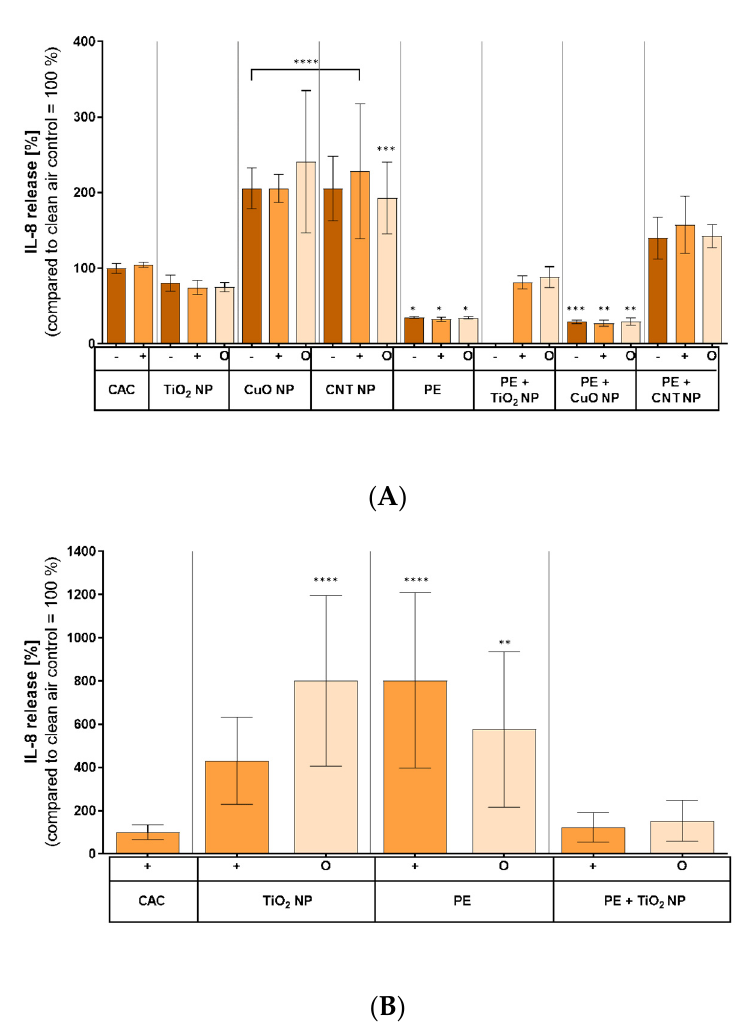
Figure 8. Inflammatory response of A549 cells ( A ) and MucilAir™ tissue ( B ) 24 h after exposure to combustion-generated aerosols compared to a clean air control (100%). Both cell systems were exposed to the correspondent aerosols for 4 h, as previously described, and incubated for another 20 h afterward, following IL-8 detection in basal media. Clean air controls exerted IL-8 levels of about 2000 pg/mL on average. Shown are the mean values of at least three independent experiments ( n = 3) ± standard deviation (SD). Statistically significant by using one-way analysis of variance (ANOVA), followed by post hoc Dunnett’s test; * p ≤ 0.05; ** p ≤ 0.01; *** p ≤ 0.005; **** p ≤ 0.001. − : normal aerosol exposure; +: exposure under enhanced particle deposition; O: exposure of a filtered